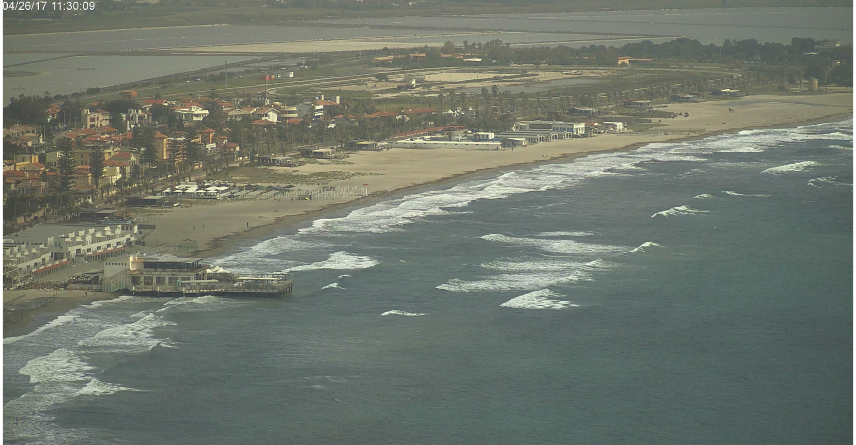
Figure 1. Snapshot of the Poetto beach captured by the video camera system during the moderate swell (significant wave height H s = 1.27 m) occurred on 26 April